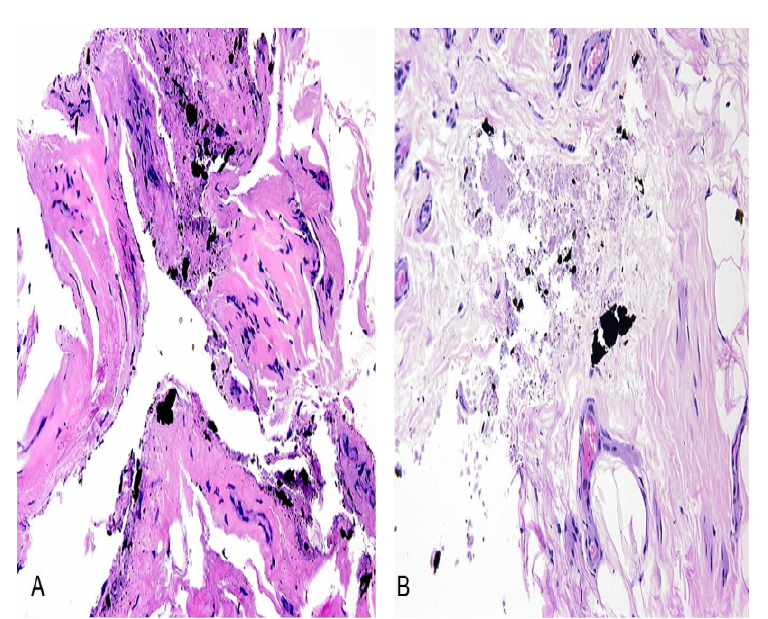
Figure 4. Case 2: Hematoxylin & eosin (H&E) stained section containing ( A ) pausicellular fibrous tissue and scattered black fragments and ( B ) necrotic debris admixed with black material, but no significant inflammation. Original magnification